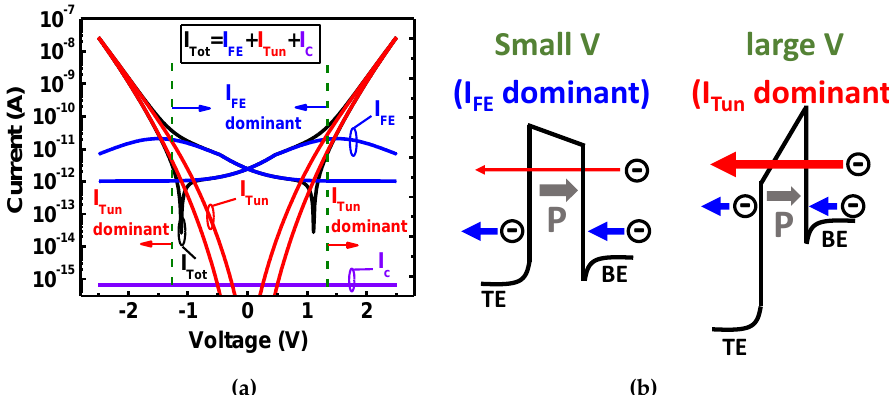
Figure 5. ( a ) Modelling and ( b ) schematic band diagrams for the current composition of HZO with [Zr] = 50%. The I tot is composed of the low I Tun and the high I Tun for the small and large bias, respectively.